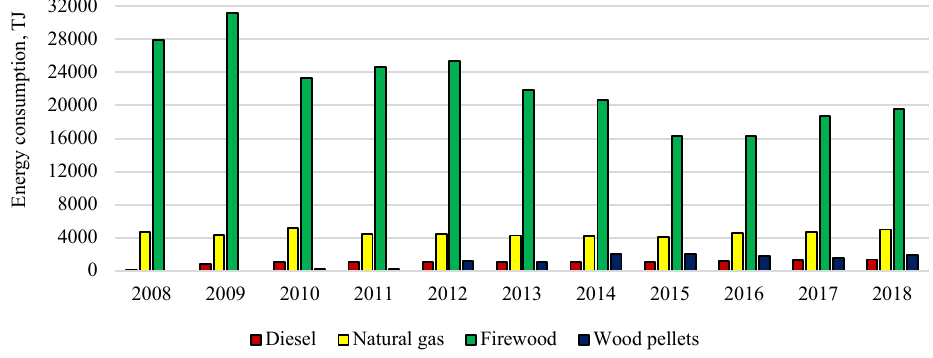
Fig. 1. Consumption of diesel, natural gas and wood biomass (firewood and wood pellets) in the Latvian household sector over 10 years [3]. Emissions of PM from households is currently a problem for Latvia. The above described flue-gas treatment technologies foresee the use of biomass fuels in boilers, while the equipment themselves are intended for use in technical spaces and industrial buildings due to their large size. Various types of pollution, including noise, occur during the lifetime of installations. Considering all types of pollution is an essential step for integrating similar equipment into the household